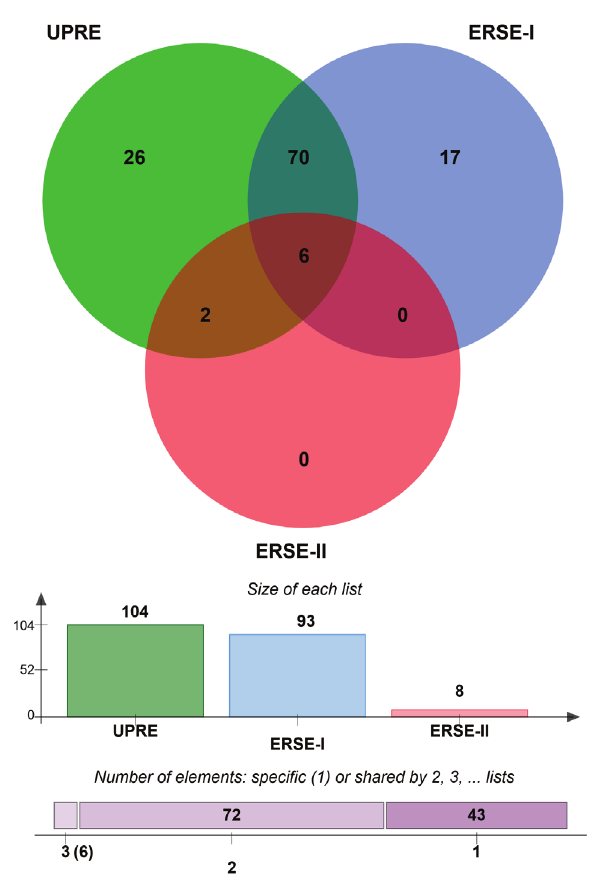
Supplementary Figure 3. Comparison of UPRE and ERSE elements in the promoter region of UPR genes that are upregulated in HD.